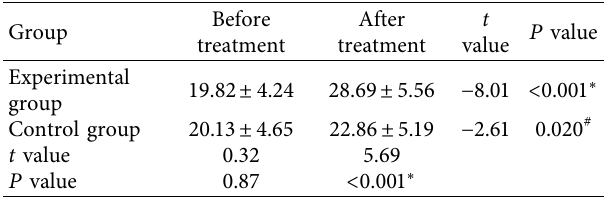
Table 2: Comparison of the scores of the RSES scale between the experimental group and control group before and 8 weeks after